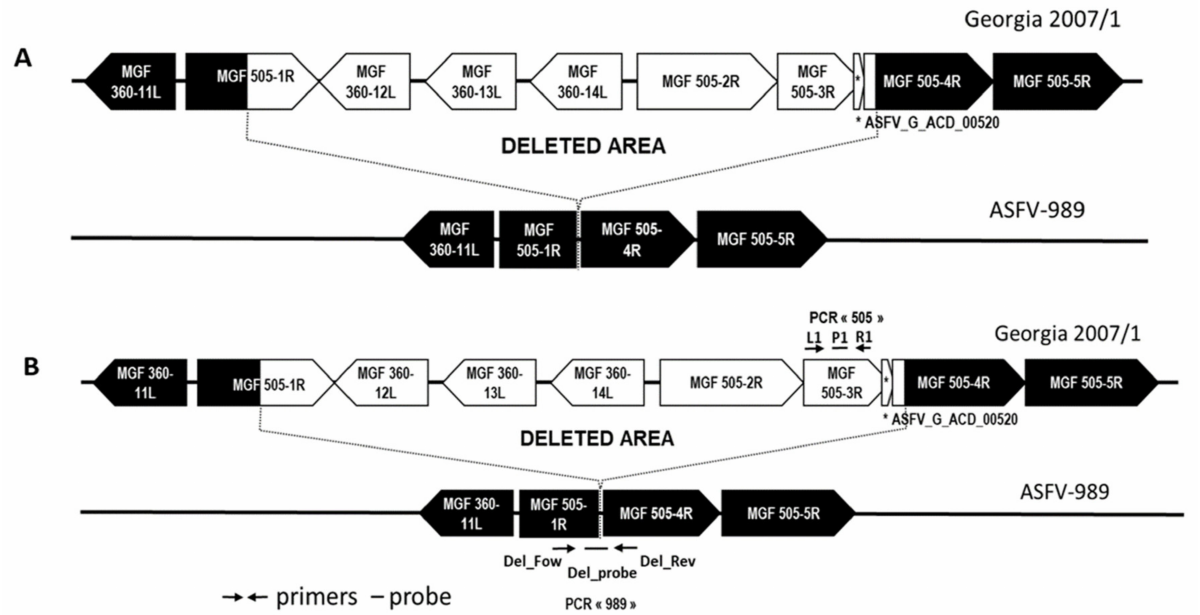
Figure 1. Representation of the genes and the DIVA PCR system in the deleted region of ASFV-989 strain. ( A ) Comparison of the Georgia 2007/1 and ASFV-989 genomes at the site of the deletion. ( B ) Position of the primers and probes for PCR 505 (L1, P1, and R1) to detect the Georgia 2007/1 strain and PCR 989 (Del_Fow, Del_Probe, and Del_Rev) to detect